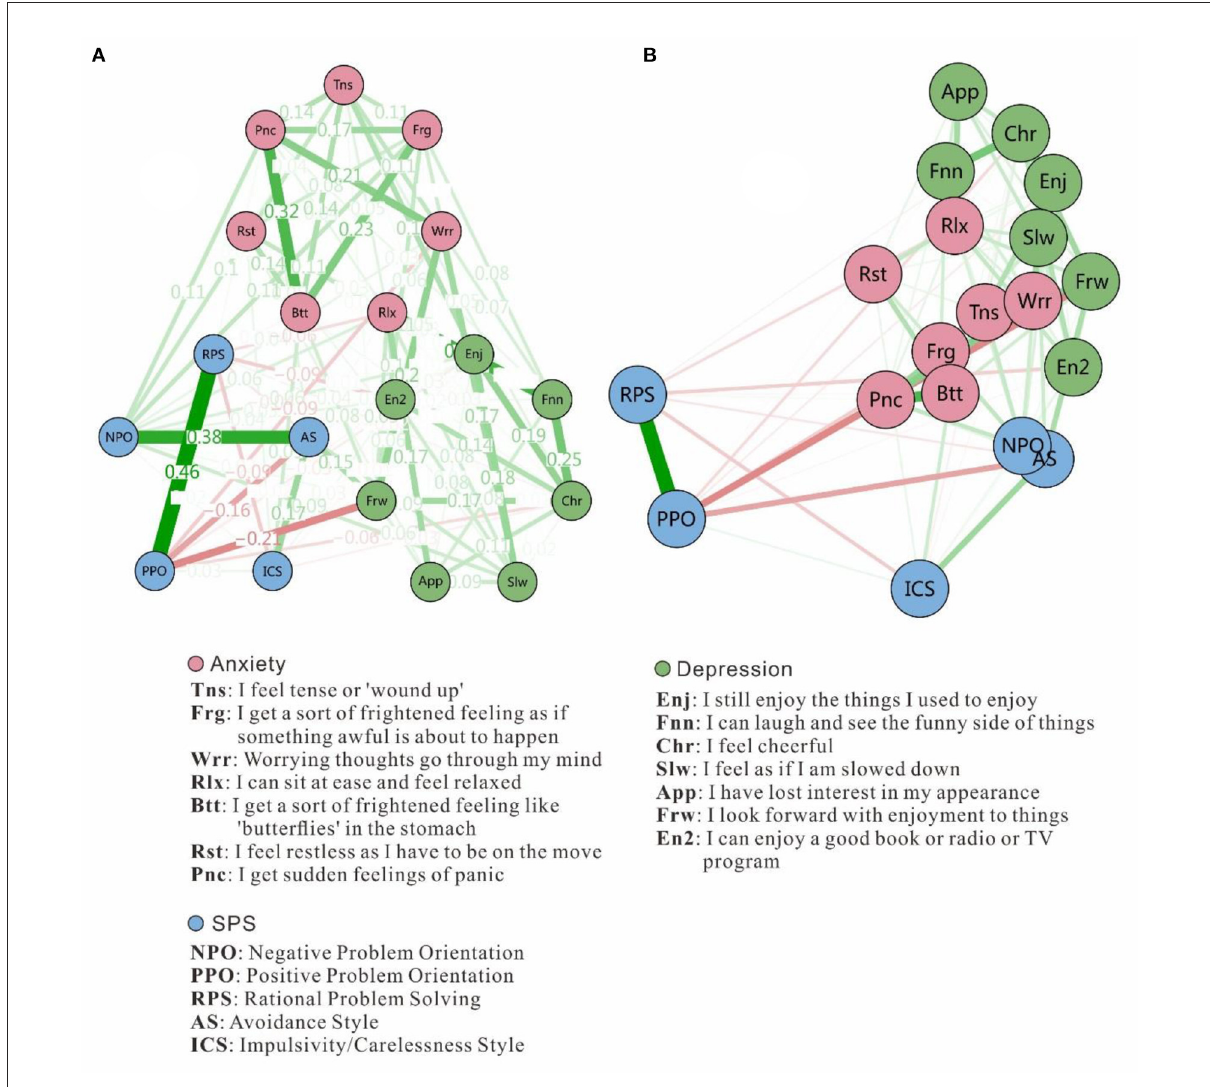
FIGURE1 Estimated network structure based on a sample of 190 adolescents. The network structure is a GGM, which is a network of partial correlation coefficients. Green edges represent positive correlations and red edges indicate negative correlations. The thickness of the edge reflects the magnitude of the correlation. (A) Network structure with the “circle” layout for easy viewing, but it is important to note that the node positions don’t indicate Euclidean distances. (B) Network structure with MDS, showing proximities among variables as distances between points in a low-dimensional